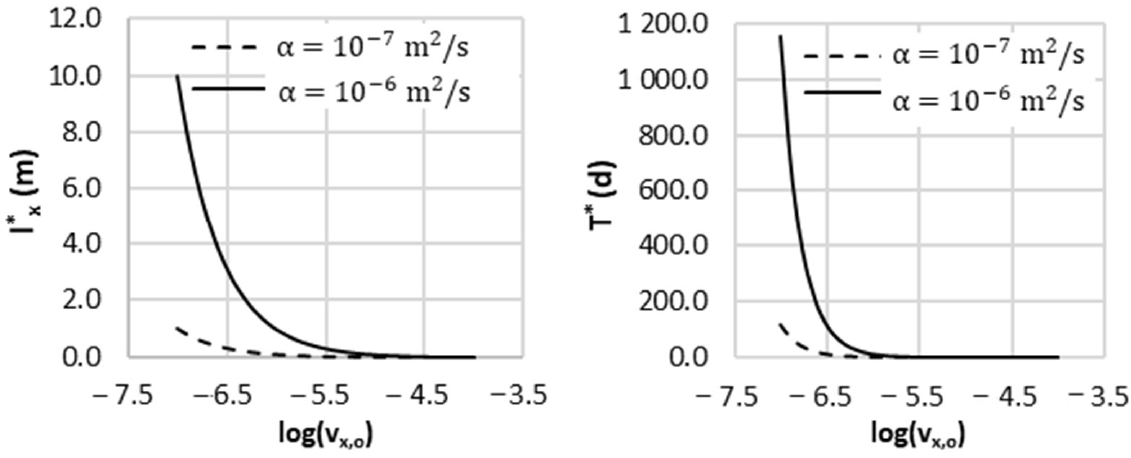
Figure 7. Dependences l ∗ x − log ( v x,o ) and τ ∗ − log ( v x,o ) .